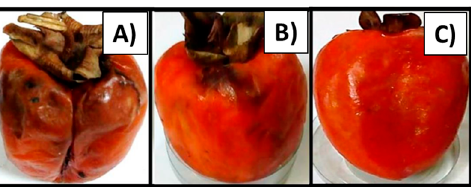
Figure 5. Illustrative example of edible coating: protection of persimmon fruits ( Diospyros kaki L.) using edible coatings from nanochitosan ( B ) and rosmarinic acid-mediated selenium nanoparticles ( C ) compared with the uncoated fruit ( A ) after 14 days of storage; images were taken and combined from the literature [91].